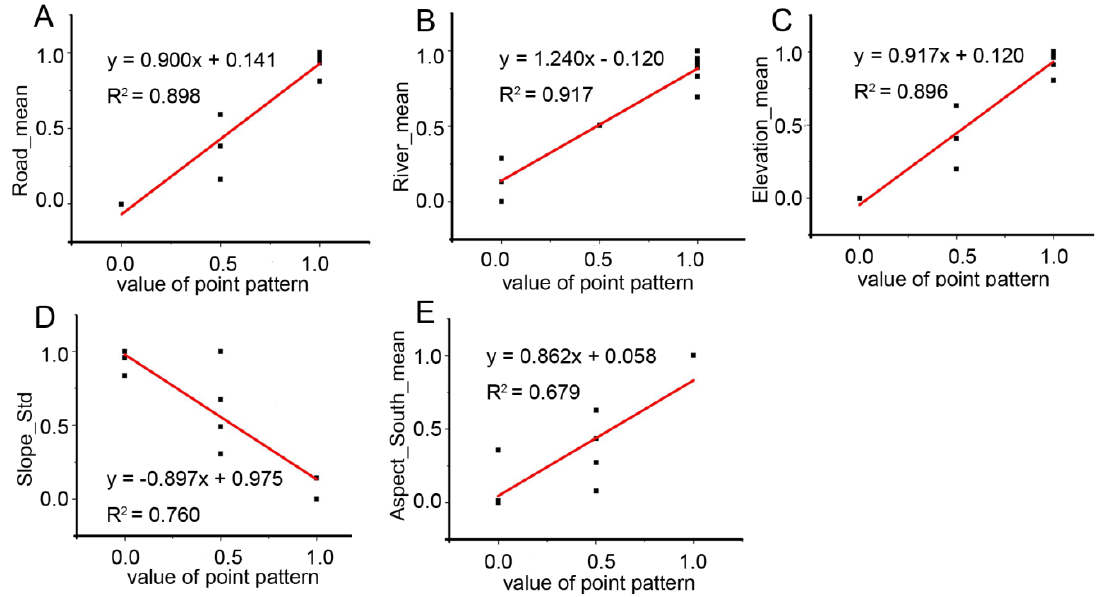
Figure 4. Relationships between different geographical association variables and value of point pattern in different counties: ( A ). Yueqing; ( B ). Tiantai; ( C ). Wenzhou; ( D ). Pingyang; ( E ). Wencheng. (After normalization processing we got 0.0 for regular pattern, 0.5 for random pattern and 1.0 for cluster pattern (lateral axis). For the same processing we got the value of geographical association variables from 0.0 to 1.0 (vertical